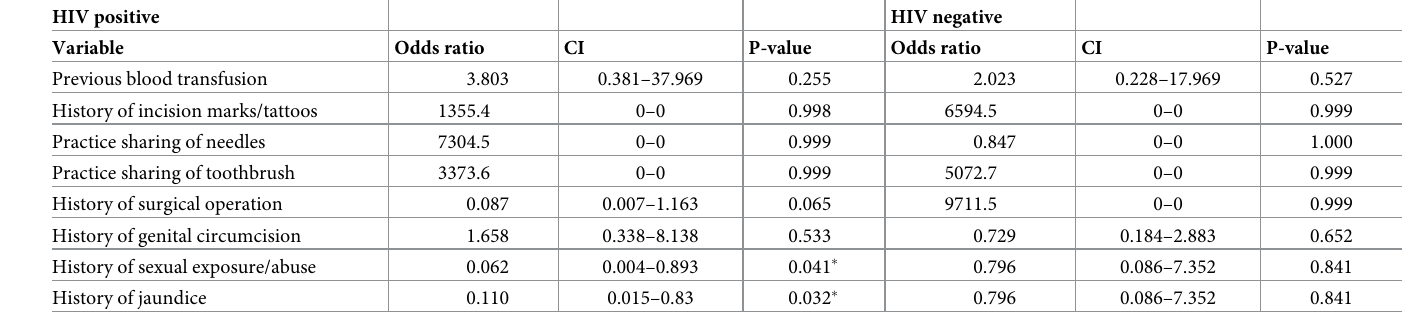
Table 5. Binary logistic regression showing the adjusted odds ratio of the determinants of hepatitis B infection among HIV infected and HIV na ï ve children. HIV